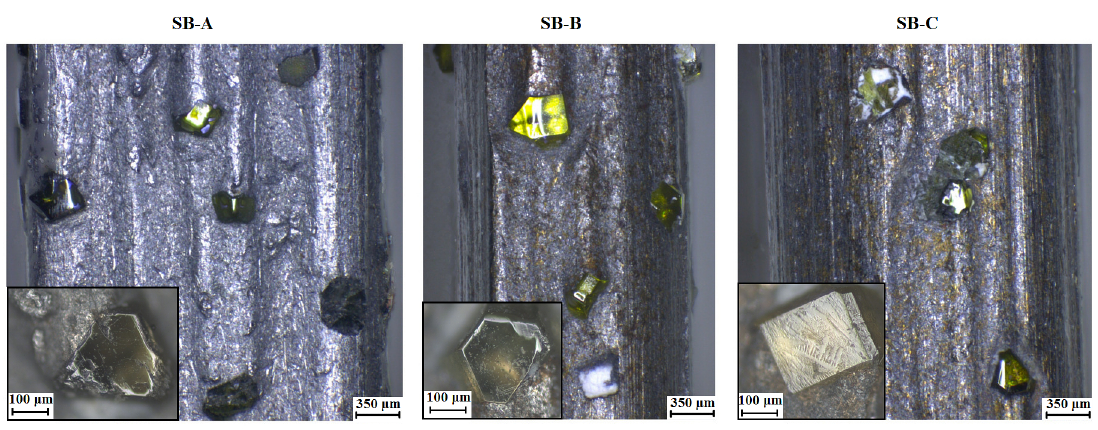
Figure 3. Grain size, thickness and matrix–diamond distribution for each type of blade.